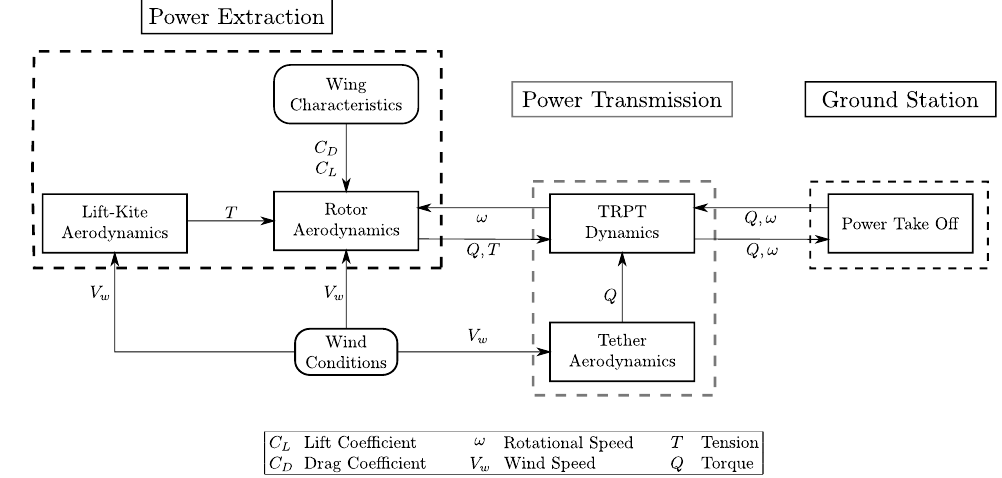
Figure 2. Block diagram of the rotary AWES (key variables